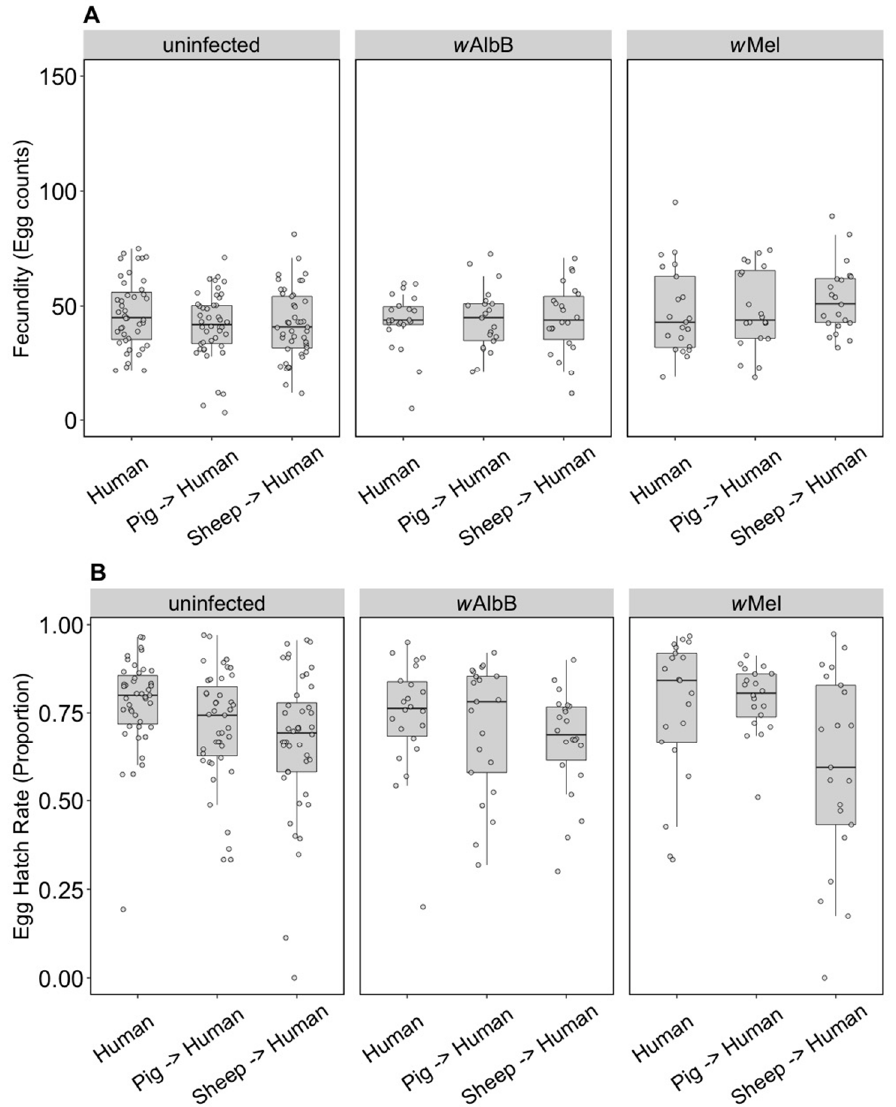
Figure 2. Comparison of fecundity and egg hatch rates across infection types (uninfected, w Mel, w AlbB) when females were fed on human blood but parents were fed on different blood sources (human, pig, sheep). ( A ) Fecundity (egg counts); ( B ) egg hatch rate (proportion). Each dot indicates the egg count and egg hatch rate of an individual female. The boxplots represent the first to the third quartiles around the median (horizontal grey line) and the vertical bars represent the 1.5 interquartile of the lower and upper quartiles. Around 24 females per blood source and generation were tested.